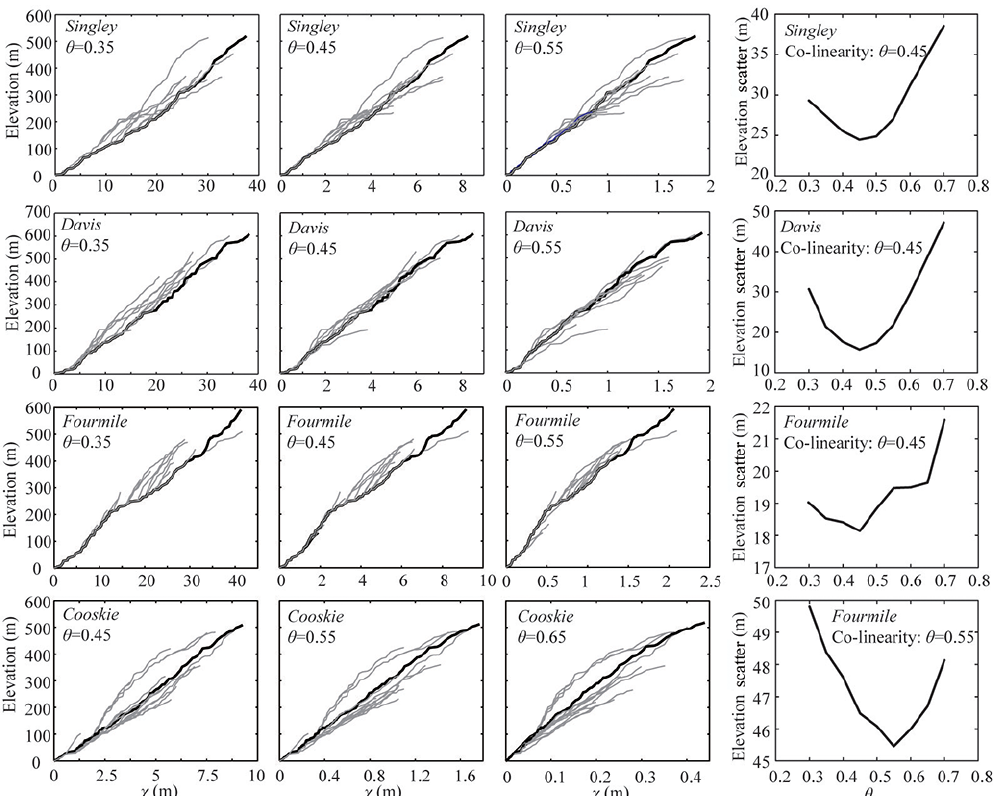
Figure 10. Concavity values that maximize the co-linearity of the main stem with its tributaries. Black thick lines in the χ − z plots are stems.